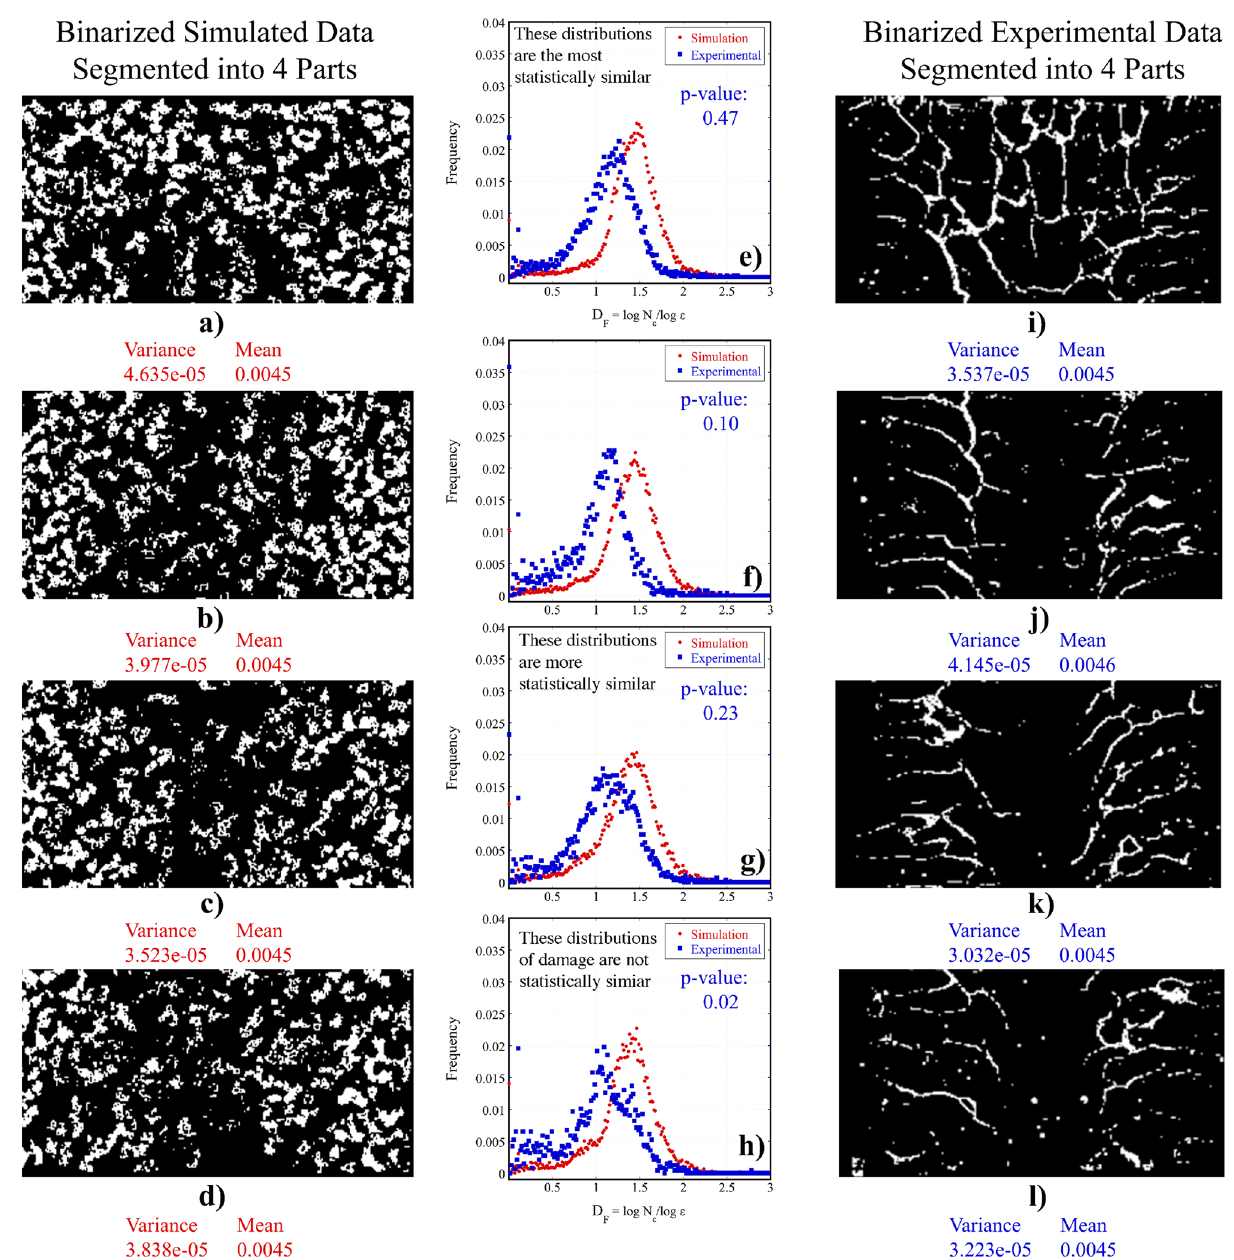
Figure 11. Sections of the simulated ( a – d ) and experimental data ( i – l ), plotted with histograms that compare the average distribution of the fractal dimension in each section for the simulated versus the experimental damage and estimated variances, means, K-statistics and p-values for each